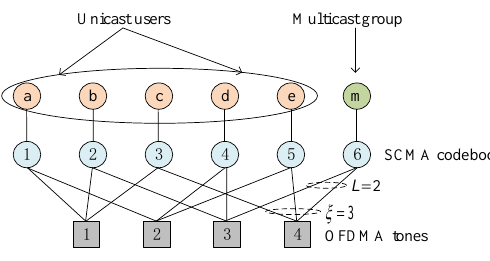
Figure 2. An exemplary mapping between SCMA codebooks and OFDMA